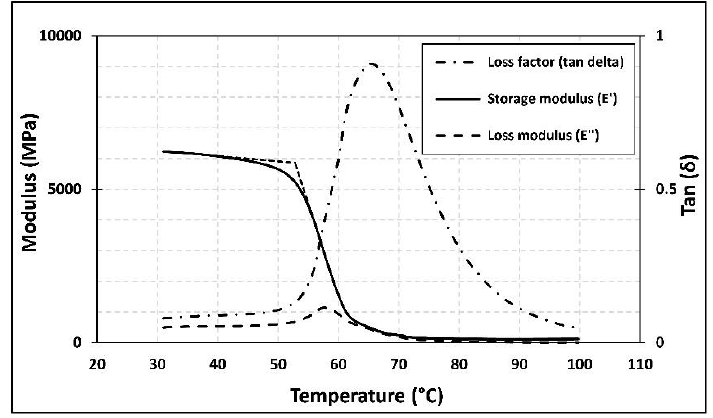
Figure 6. Dynamic mechanical analysis (DMA) test results.